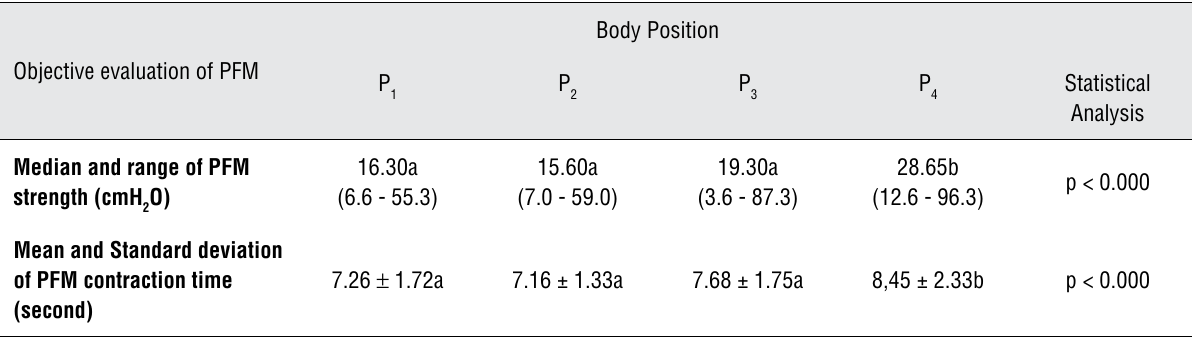
Table 2 - Maximum amplitude (cmH O) (median and range) and time (second) (mean ± sd) of PFM contractions in objective 2 O) in different positions. Different lower case letters indicate when evaluation of PFM strength using perineometer (cmH 2 groups were significantly different at the same